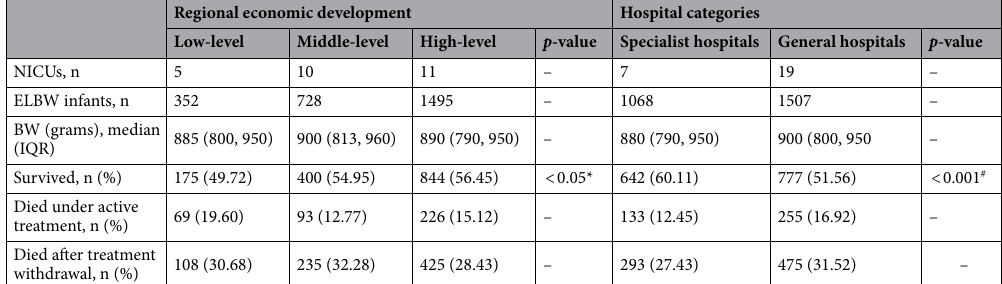
Survived, n (%) Died under active treatment, n (%) Died after treatment withdrawal, n (%) Table 4. Differences of survival rate among regions or between hospitals. NICUs, Neonatal intensive care units; ELBW, extremely low birth weight; IQR, interquartile range. *Chi-square test linear-by-linear association. # Pearson’s Chi-square test.